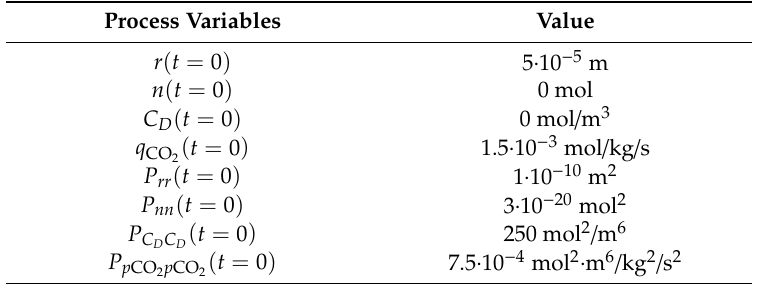
Table 2. Initial conditions of the process variables and estimation error differential equations.